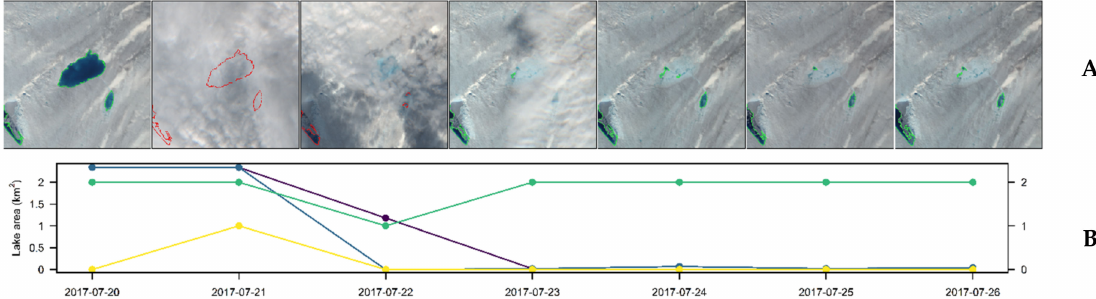
Figure 10. Rapid drainage event between 20 July 2017 and 26 July 2017. ( A ): S-2 true-color images of each day within the period, overlaid by the lake mask for the day in question (green = flagged as cloud-free, red-flagged as cloudy). ( B ): detected lake size in km 2 before (blue) and after (purple) cloud detection (left vertical axis), and flags of cloud detection by time-dependent visibility (green) and spatial cloud extent (yellow, right vertical